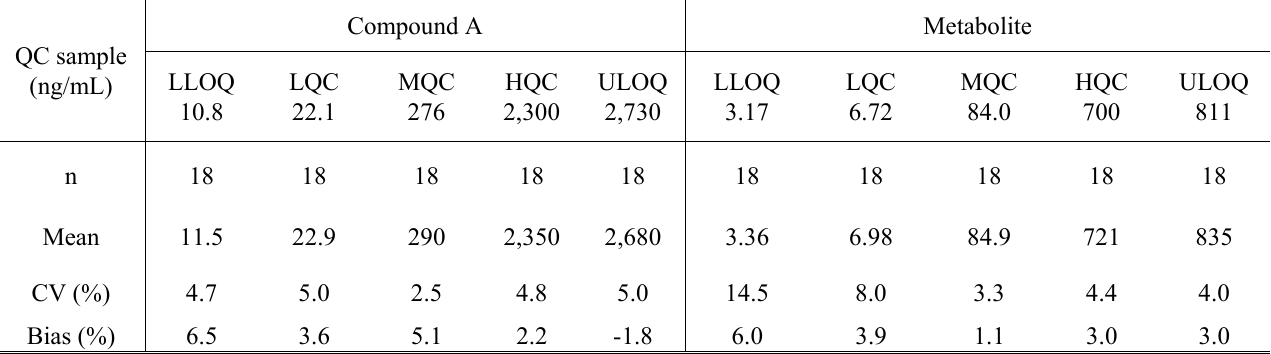
Table 2. Inter-day accuracy and precision of the LLOQ, LQC, MQC, HQC, and ULOQ evaluation samples for the dog whole blood method. Mean values in the table are the average of the back-calculated concentrations from the standard